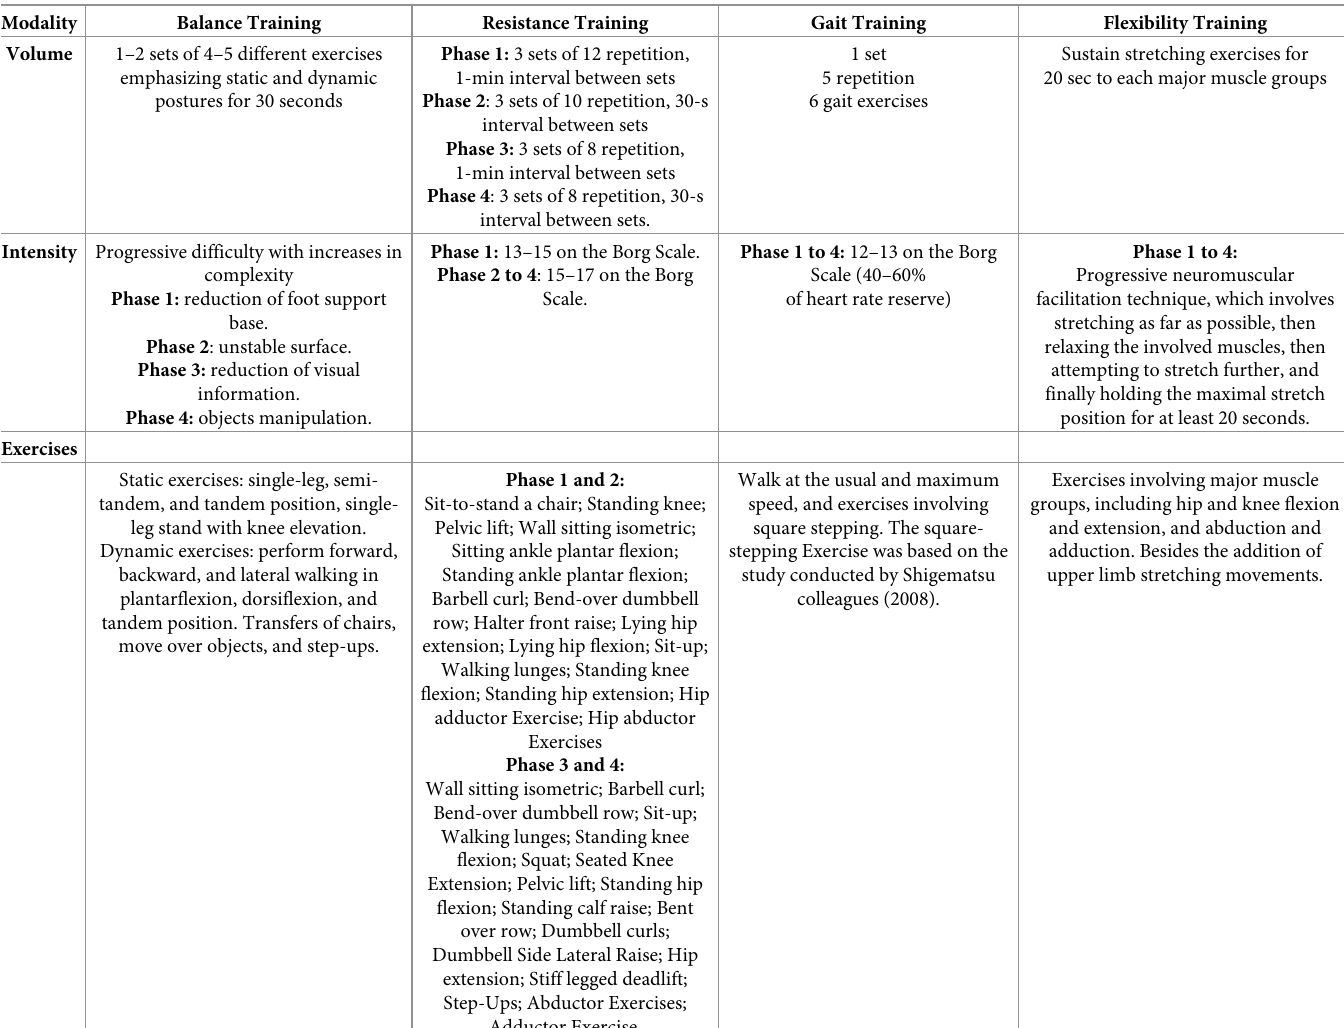
Table 1. Multicomponent exercise program